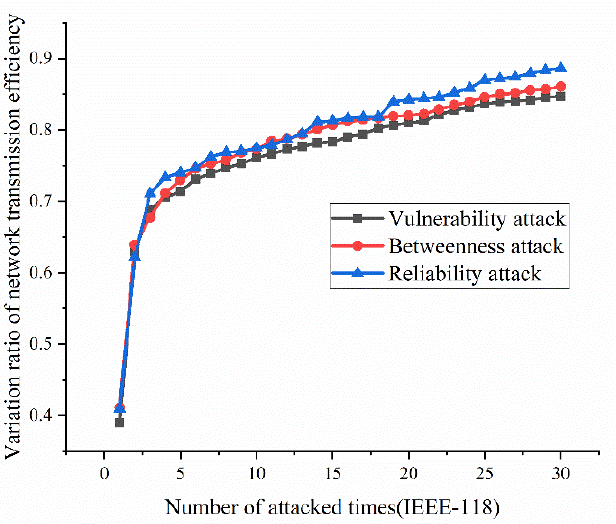
Figure 19. Load loss ratio of IEEE-118 bus system without extreme weather.